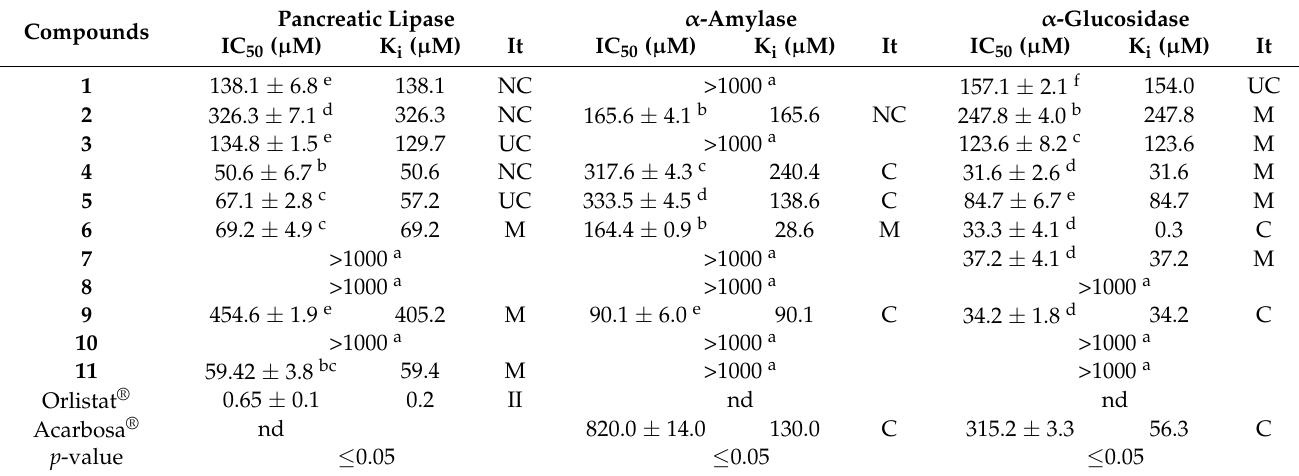
Table 2. Polyfunctional activity of compounds ( 1 – 11 ) against PL, AA and